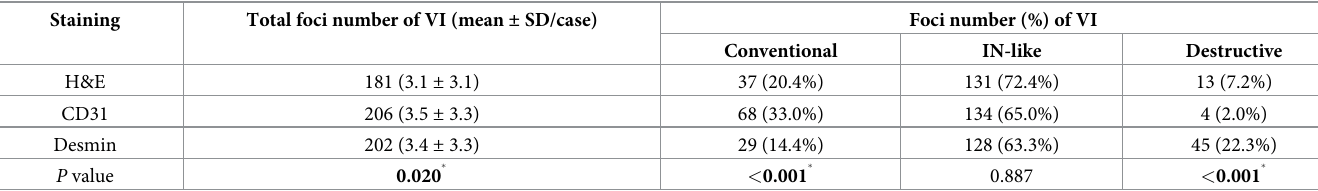
Table 2. Foci number of VI based on invasion patterns and staining methods in the test set.